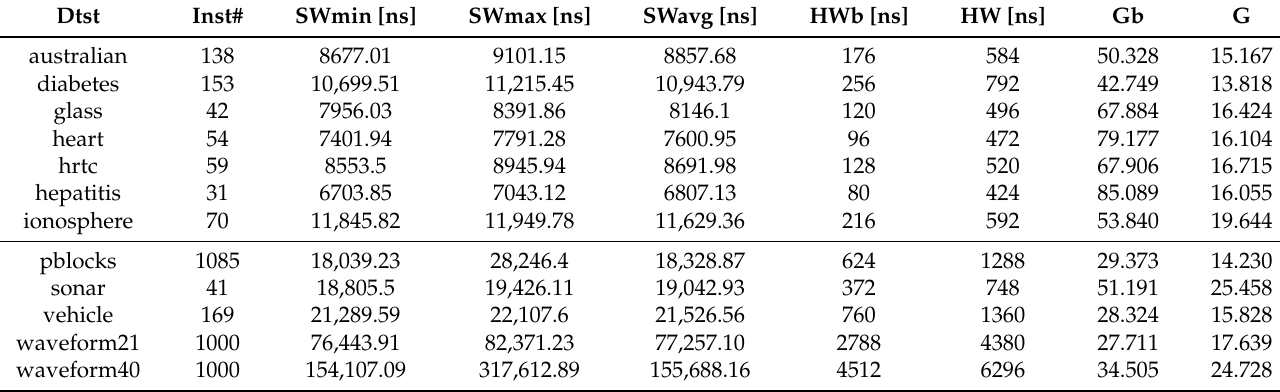
Table 12. Processing latency comparison between the software implementation of SVM classifier compared to